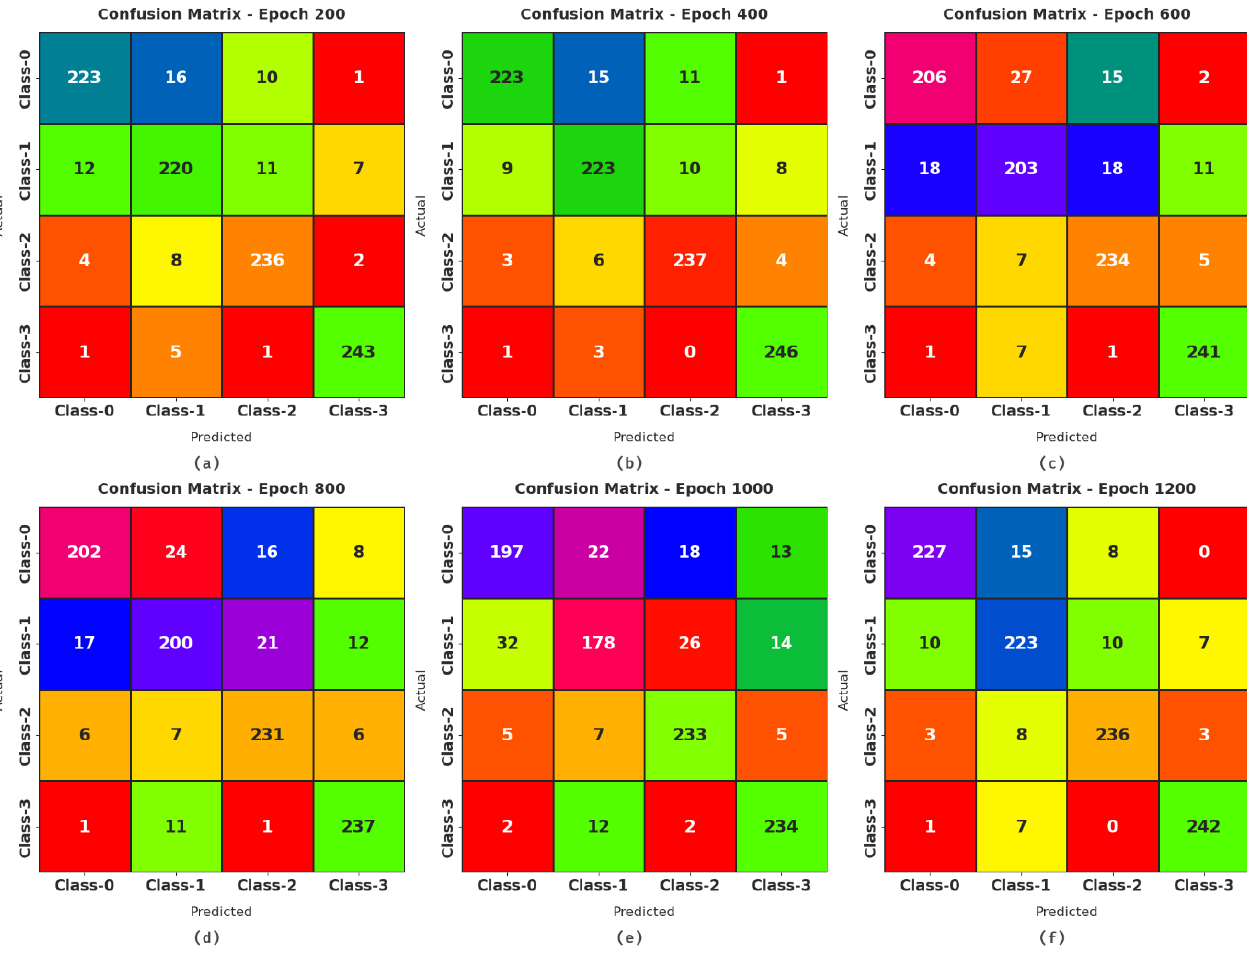
Figure 5. Confusion matrices of MDTL-ICDDC technique ( a ) epoch 200, ( b ) 400 epoch, ( c ) epoch 600, ( d ) epoch 800, ( e ) epoch 1000, and ( f ) epoch 1200.